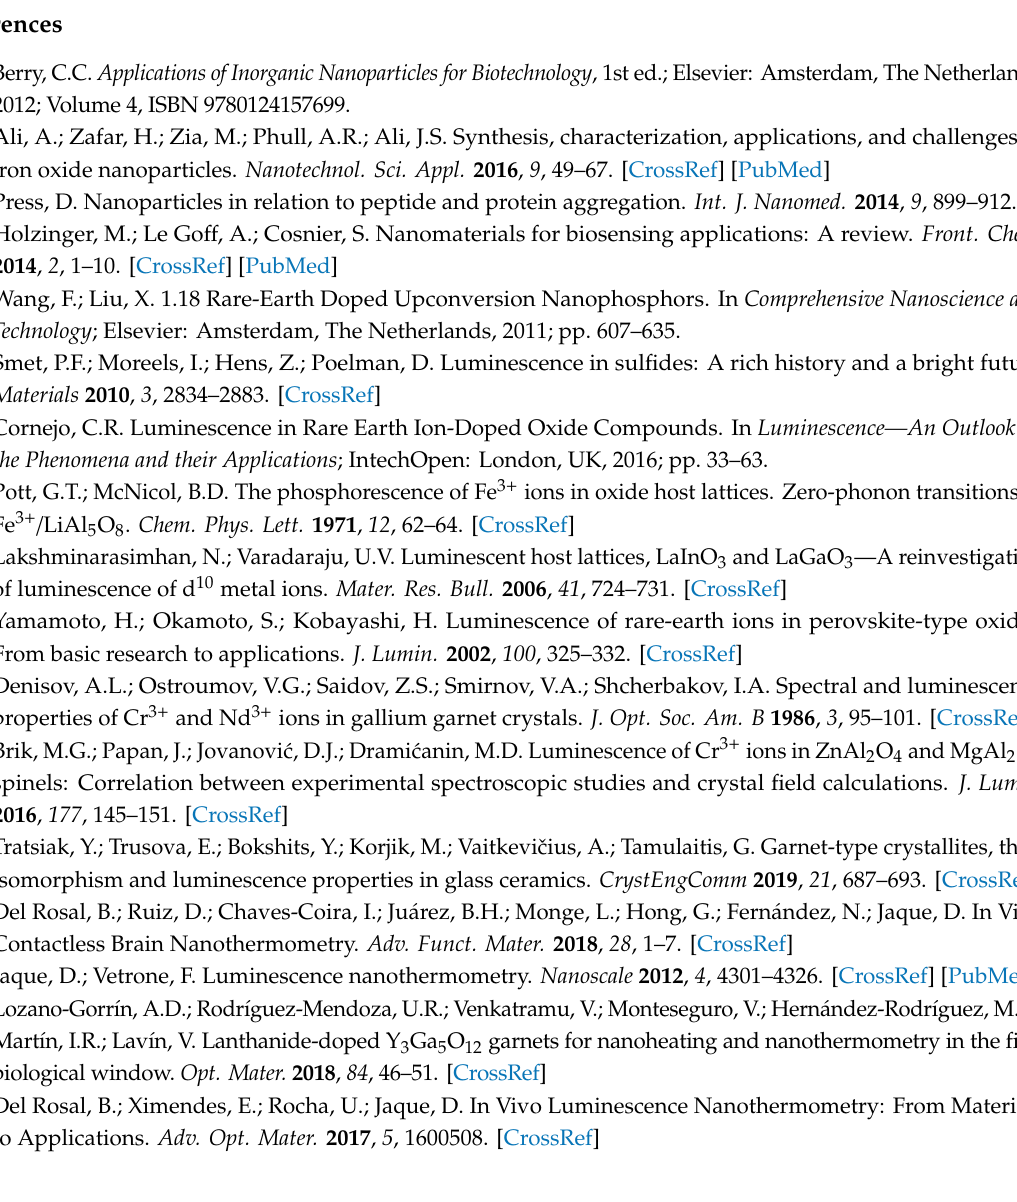
Figure S1: ( a ), ( b ), ( c ) The luminescence decay profile of V 5 + , V 4 + and V 3 + ions for di ff erent Ga 3 + , respectively; Figure S2: Emission spectra of V-doped nanocrystals recorded in the range of − 150 ◦ C–300 ◦